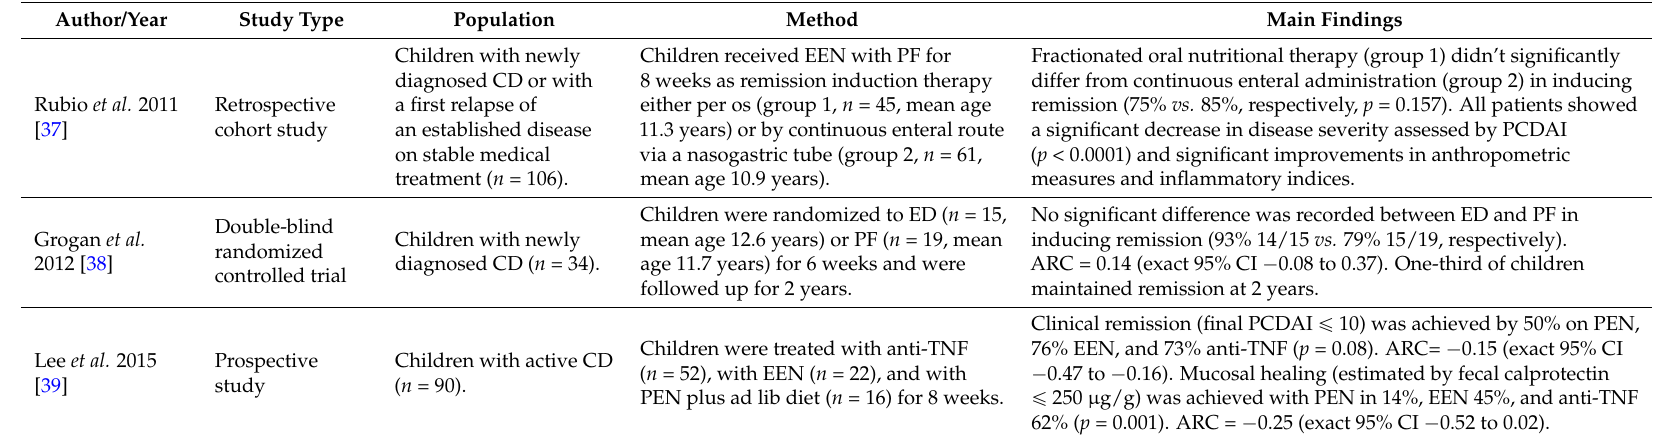
Table 4. Clinical studies comparing exclusive enteral nutrition to corticosteroids. PCDAI = Pediatric Crohn’s Disease Activity Index, ED = elemental diet, PEN = partial enteral nutrition, CS = corticosteroids, EEN = exclusive enteral nutrition, IFX = infliximab, anti-TNF = anti-tumor necrosis factor, TGF β 2 = transforming growth factor beta 2, ARC = absolute risk